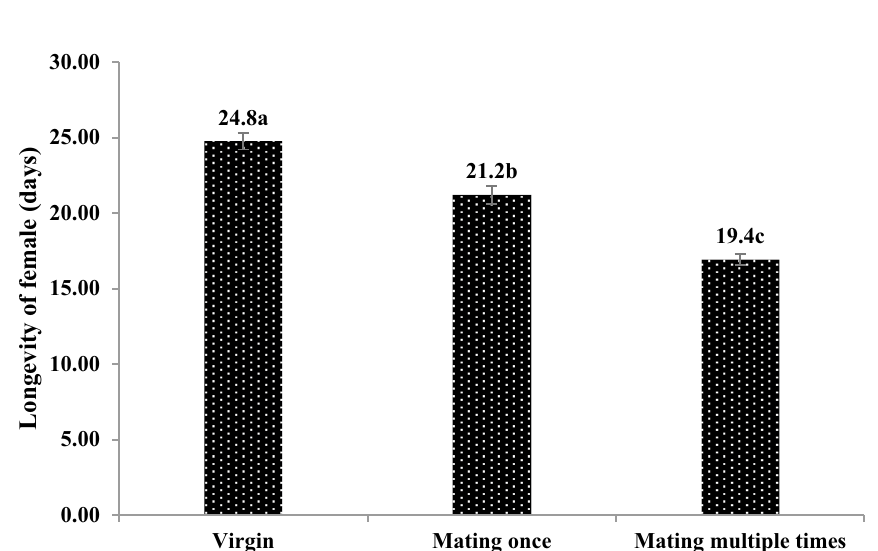
Figure 6. The longevity of female C. japonicus at different mating times. Data in the figure is mean ± standard error, different letters indicate significant differences in Duncan’s test, with a probability of